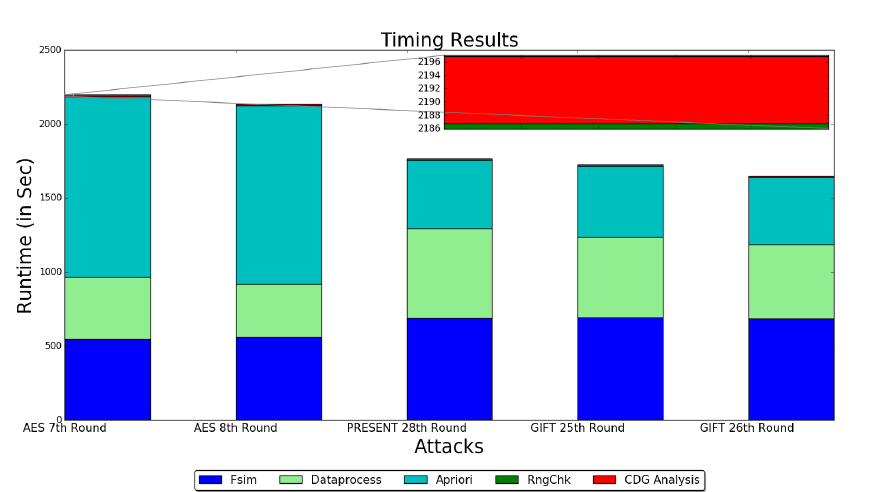
Figure 9: Runtime analysis: different components of the runtime are shown. Runtimes of RngChk and CDG based complexity analysis are found to be negligibly small (shown in